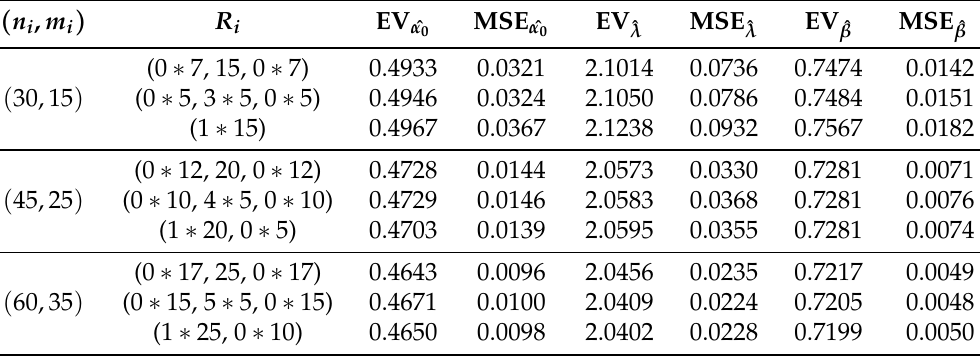
Table 1. The expected values (EV) and mean square errors (MSE) of the maximum likelihood estimates for different sample sizes ( n i , m i ) and different censoring schemes R i